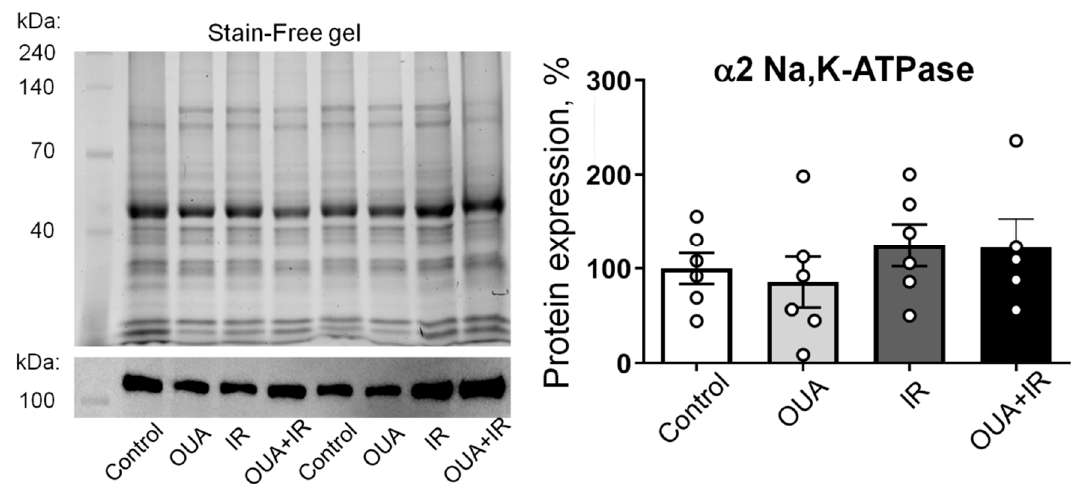
Figure 6. Ionizing radiation and 6-day ouabain treatment did not induce any significant changes in the α 2 Na,K-ATPase abundance in the rat diaphragm muscle. The protein content of the α 2 Na,K-ATPase in muscle from control rats, rats chronically treated with ouabain (OUA), rats exposed to ionizing radiation (IR), and rats chronically treated with ouabain and exposed to IR (OUA+IR). Left panel shows representative total protein load detected with Stain-Free gel and the corresponding Western blots for the α 2 Na,K-ATPase, used for semi-quantification of α 2 isoform abundance, i.e., a ratio between a specific α 2 Na,K-ATPase band intensity over total protein load for the same probe. The right panel is the averaged results of semi-quantification of the α 2 isoform protein abundance. The number of muscles corresponds to the number of symbols; n = 5 − 6 in all groups.